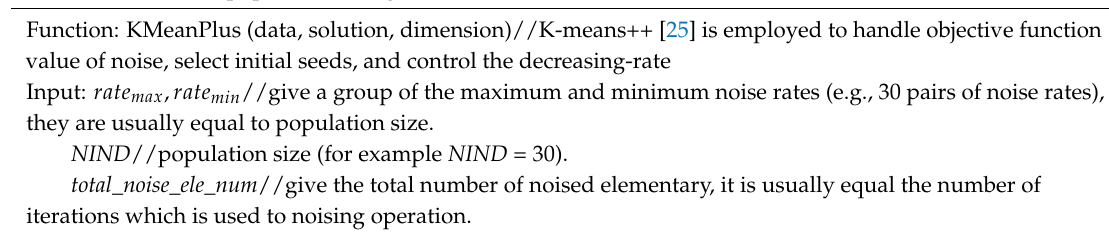
Figure 3. Diagram of the initial population using the noise method and K-means++. Algorithm 1. Initial population using noise and K-means++